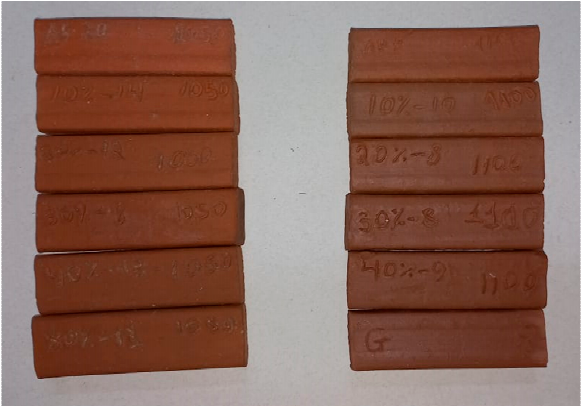
Figure 2. Ceramic specimens made from clay and ornamental stone waste.